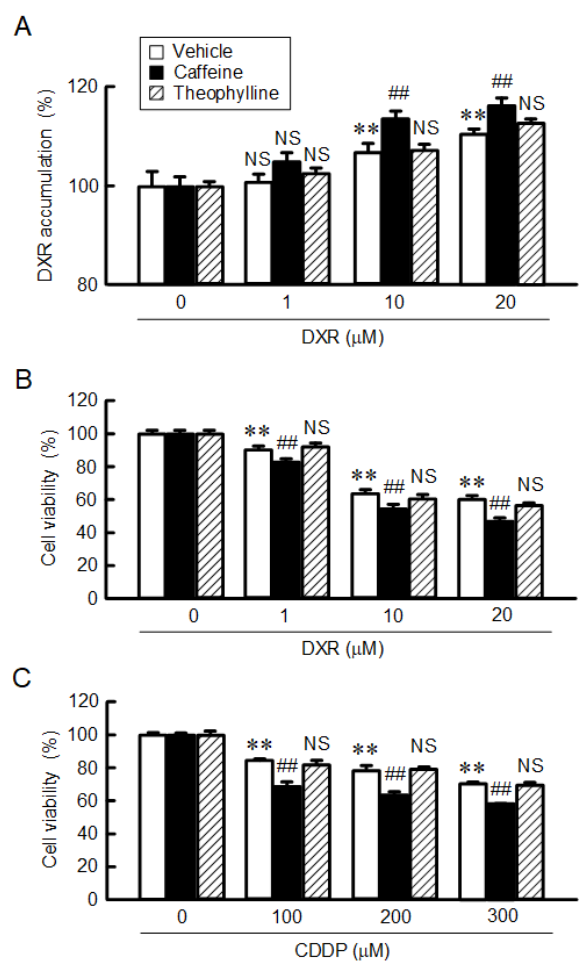
Figure 8. Enhancement of anticancer-drug-induced toxicity in spheroids by caffeine. ( A ) Spheroids were incubated in the absence (vehicle) or presence of 200 μM caffeine or theophylline for 1 h. The fluorescence intensity of DXR in the spheroids was examined using fluorescence microscopy and represented as a percentage relative to 0 μM (autofluorescence). ( B , C ) After incubation of the spheroids in the absence (vehicle) or presence of 200 μM caffeine or theophylline 24 h, followed by incubation with DXR and CDDP at the indicated concentrations. Cell viability was measured using a CellTiter- Glo 3D Cell Viability Assay kit and represented as a percentage relative to 0 μM DXR. n = 4 – 6. ** p < 0.01 compared with 0 μ M DXR or CDDP. ## p < 0.01 compared with vehicle. NS p > 0.05 compared with 0 μ M or vehicle.